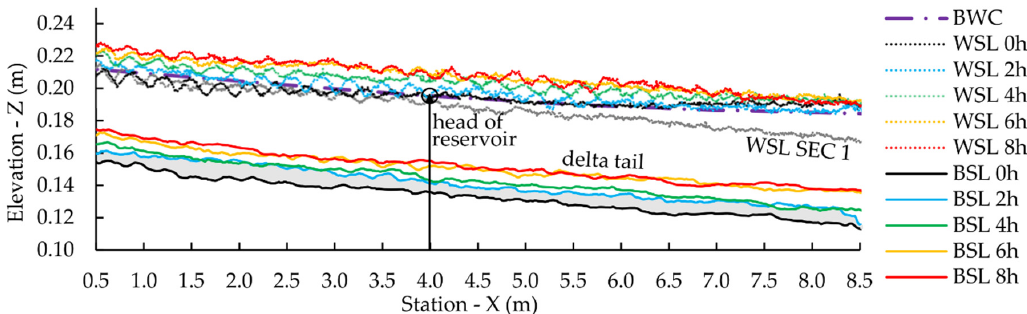
Figure 7. Bed and water surface profiles for D3 at the head of the reservoir at a flow rate of 0.7 × HQ1 during turbine operation. The profiles were measured every two hours. The grey line represents the water surface profile of the free-flowing section which corresponds to the bed levels at hour 0 (black line). The head of the reservoir is located at X = 4.0. WSL = water surface levels, BSL = bed surface levels, BWC = calculated backwater curve.